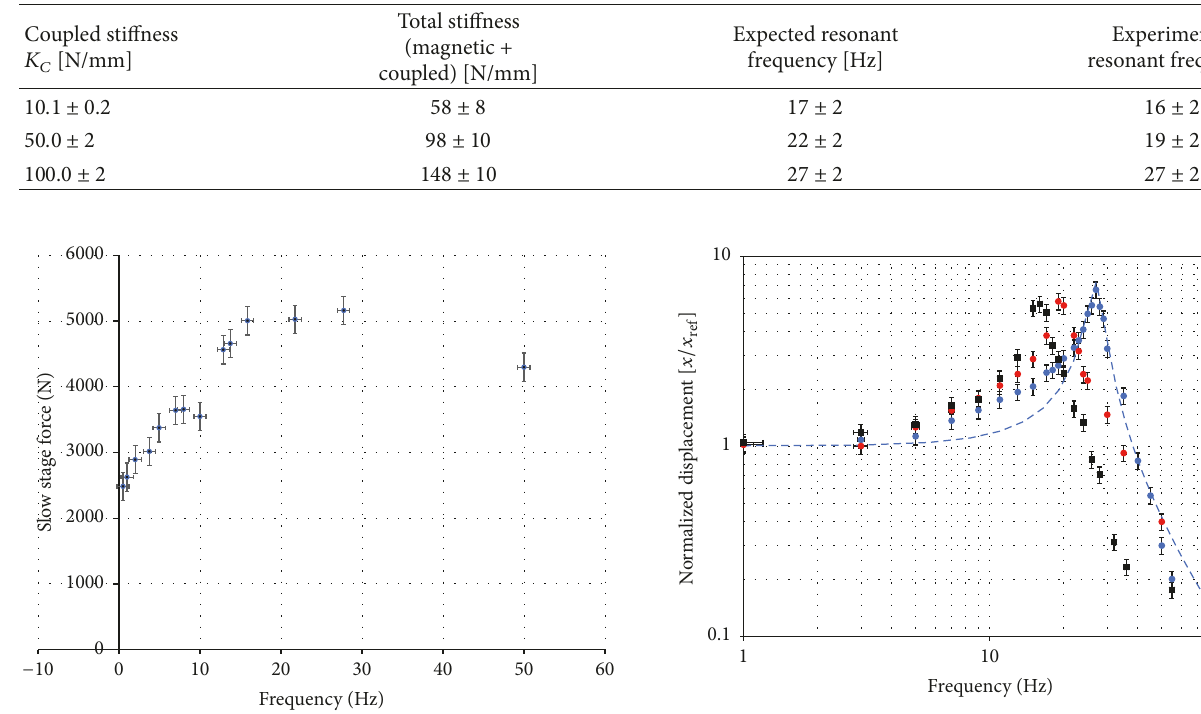
Figure 18: Slow stage force versus frequency for the 𝑍 -transmitter with 0.7 mm input amplitude.